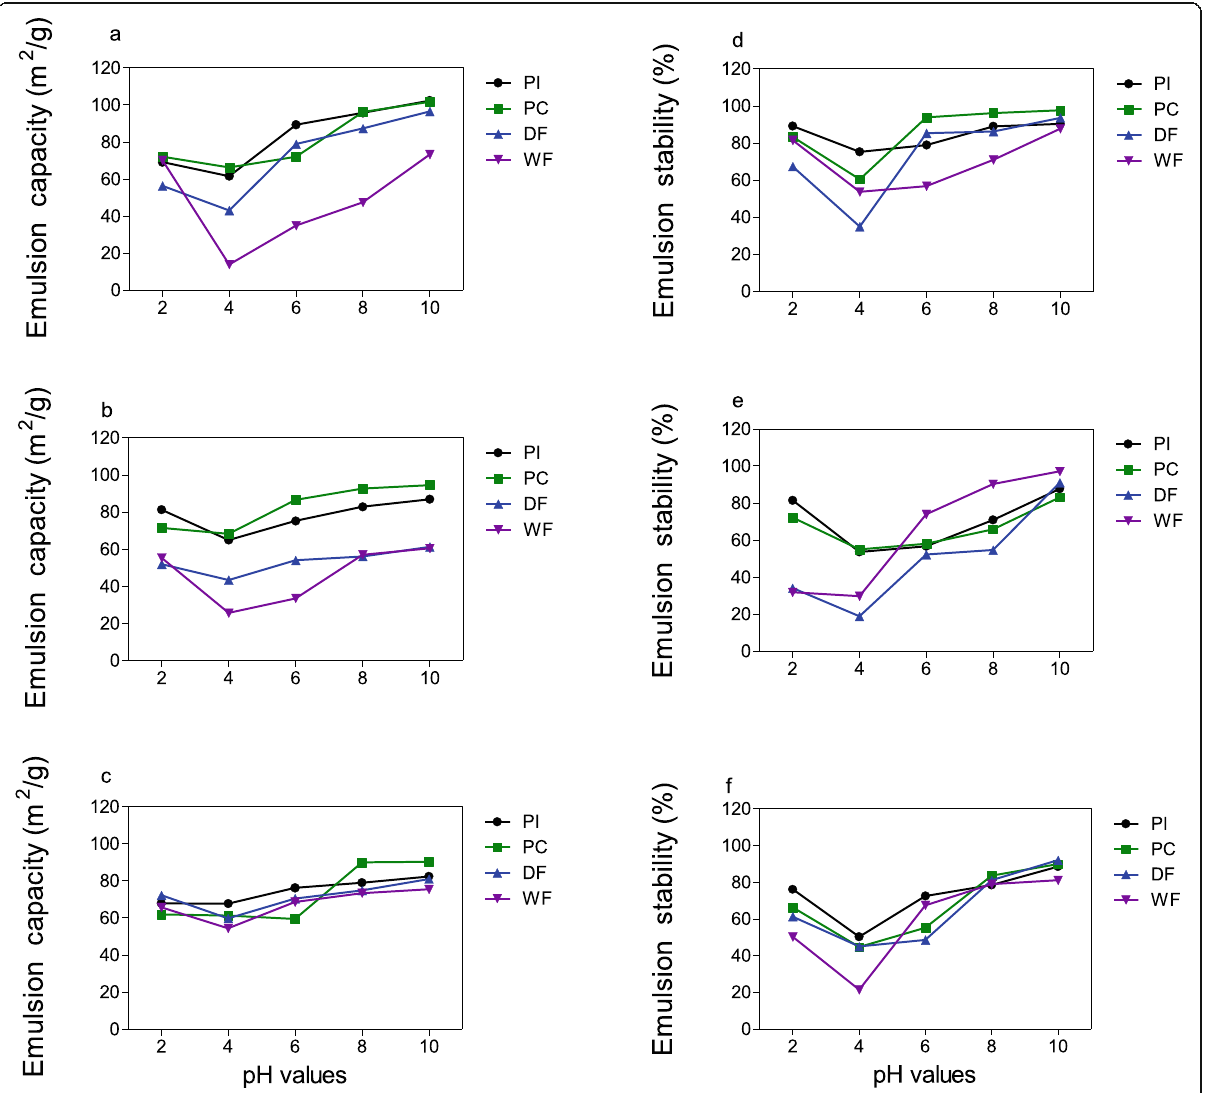
Fig. 4 Influence of NaCl concentrations and pH on the emulsion capacity of okra seed samples at a absence of salt b 0.5 M NaCl concentration c 1.0 M NaCl concentration; and emulsion stability at d in the absence of salt e 0.5 M NaCl concentration f 1.0 M NaCl